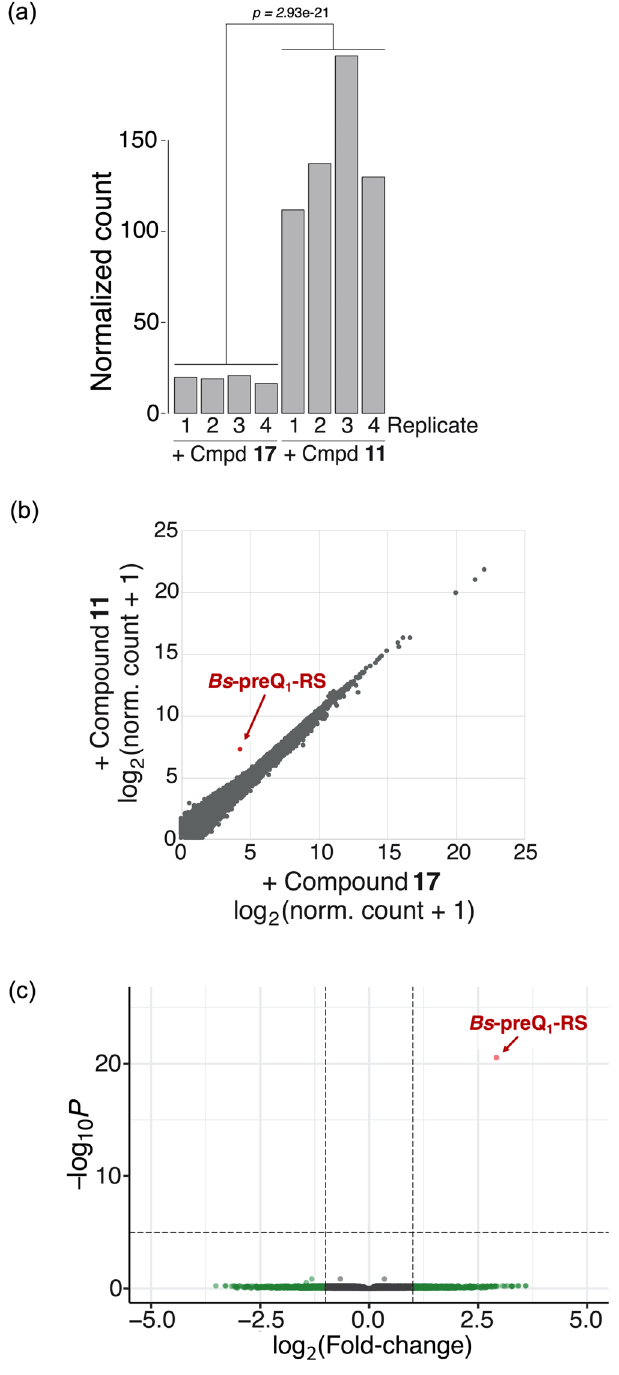
Fig. 6 Selective enrichment of Bs -preQ 1 -RS aptamer by 11 in total human RNA with Bs -preQ 1 -RS aptamer spiked in. a Comparison of the normalized counts of the Bs -preQ 1 -RS aptamer across 11 and 17 treated samples shows signi fi cantly higher counts in all four replicates of 11 treated samples. Statistical signi fi cance was calculated by two-tailed t -test analysis. b Correlation plot showing differential gene enrichment for compounds 11 and 17 . The gene entry corresponding to the Bs -preQ 1 -RS is labeled in red. c Volcano plot from differential expression analysis between 11 and 17 . The gene entry corresponding to the Bs -preQ 1 -RS is labeled in red. p = adjusted p -value. All analyses performed on four independent replicate samples treated with 11 or 17